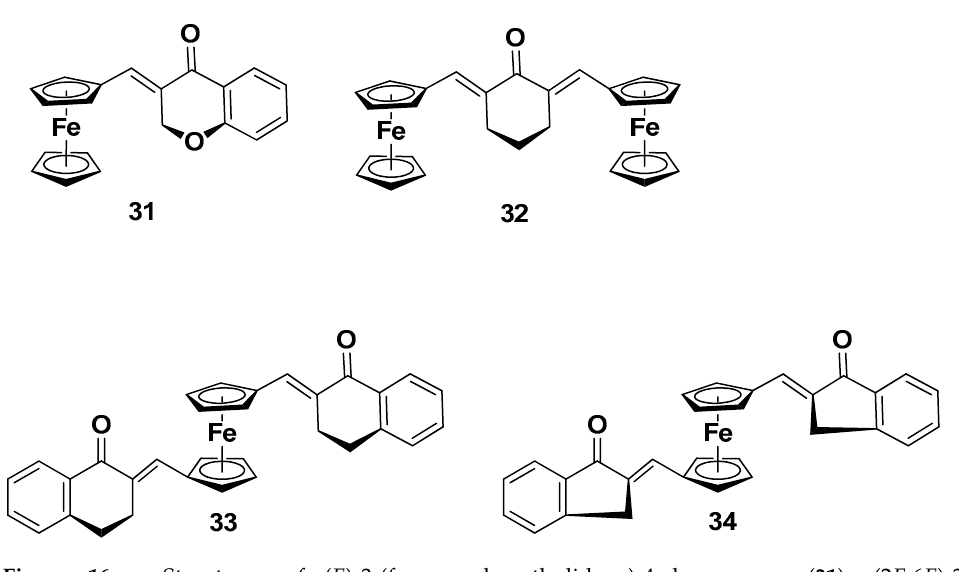
Figure 16. Structures of ( E )-3-(ferrocenylemethylidene)-4-chromanone ( 31 ), (2 E ,6 E )-2,6- bis(ferrocenylemethylidene)cyclohexanone ( 32 ), 1,1 (cid:48) -bis(( E )-1-oxo-3,4-dihydronaphthalen- (1H)-2-ylidene)methyl)ferrocene ( 33 ), and 1,10-bis(( E )-1-oxo-1,3-dihydro-2H-inden-2- ylidene)methyl)ferrocene ( 34 ) [65].